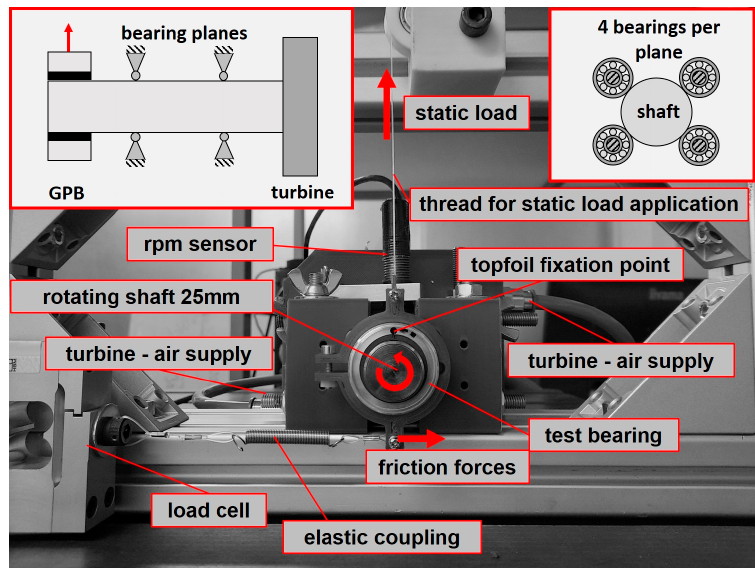
Figure 3. Illustration of the test setup for lift-off measurements.